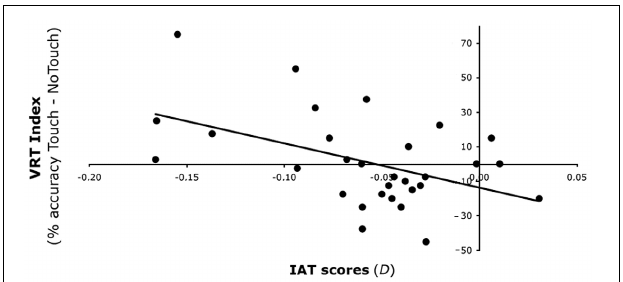
FIGURE 4 | Experiment 2 results. Relationship between VRT effect for Outgroup faces and IAT scores after Synchronous IMS. After Synchronous IMS IAT scores (on the x -axis) predicted the increase of the VRT effect for Outgroup faces (on the y -axis)—expressed as the difference in detection of bilateral tactile stimulation in the Touch and No-Touch fingers’ trajectory